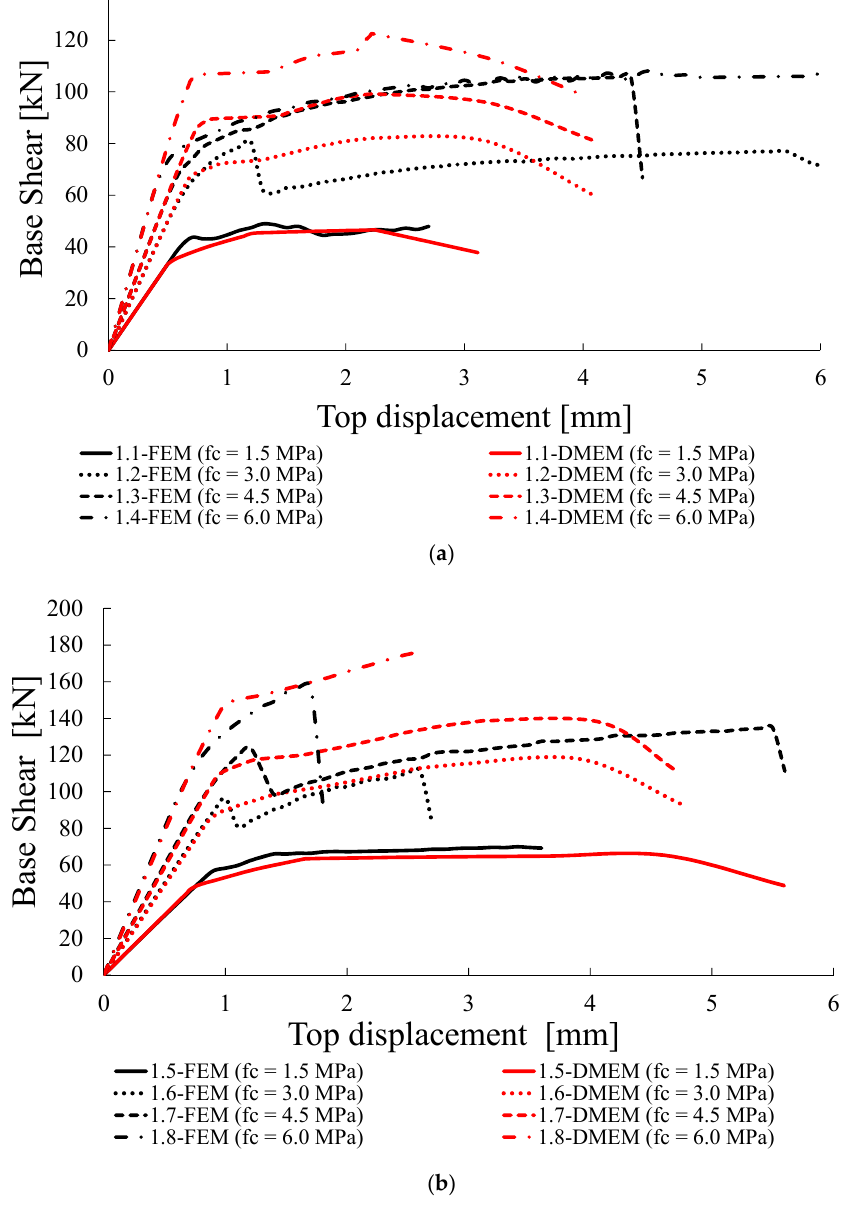
Figure 11. Capacity curves for Group A: ( a ) σ 0 = 0.3 MPa, ( b ) σ 0 = 0.6 MPa.